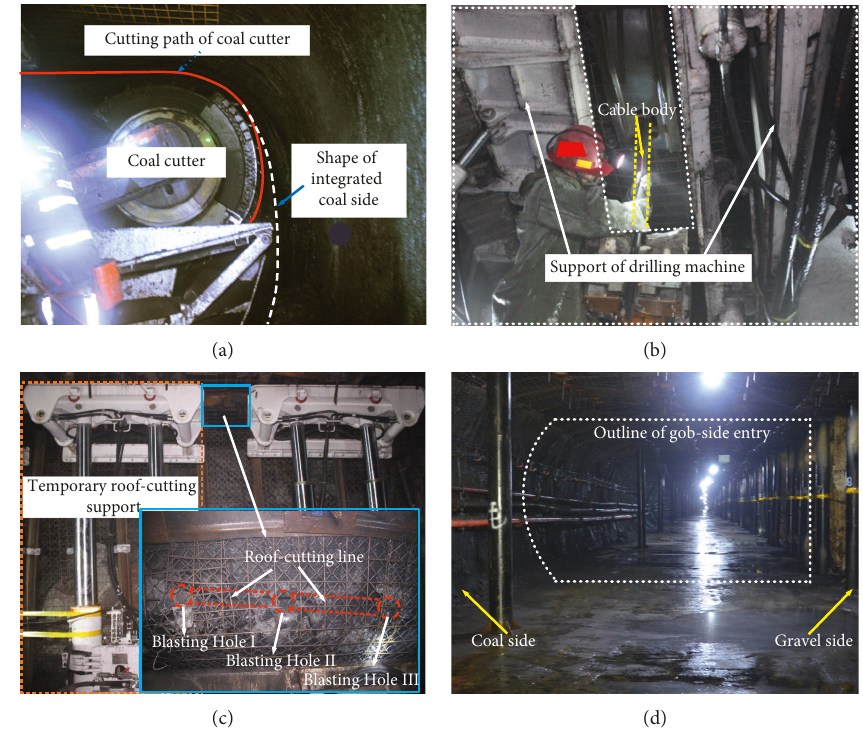
Figure 3: GEFANM process and roadway formation result on the S1201-II working face. (a) Principle of integrated coal side formation. (b) CRLDA cable mounting. (c) Directional roof cutting. (d) Final result of the formed